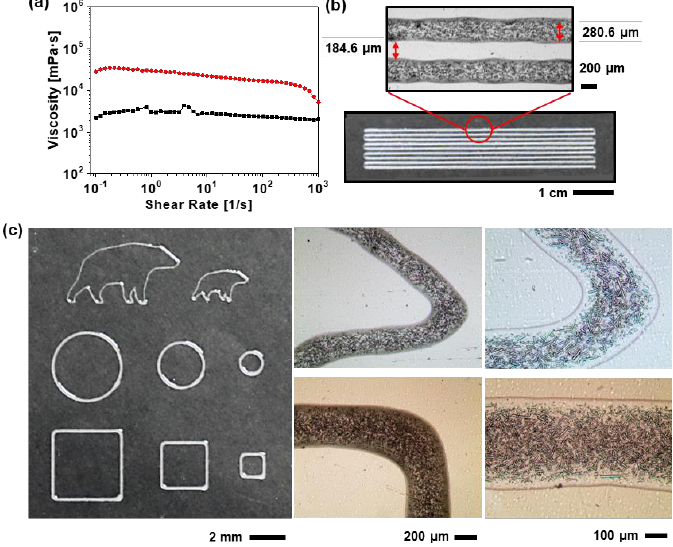
Figure 3. ( a ) Viscosity of the rigid part (with 60 wt % GF) with solvent (Black) and without solvent (Red). ( b ) Image of printed rigid part through nozzle jet printing. Inset shows a magnified optical microscopy image. ( c ) Image of variously patterned rigid part through nozzle jet printing. Inset shows a magnified optical microscopy image.